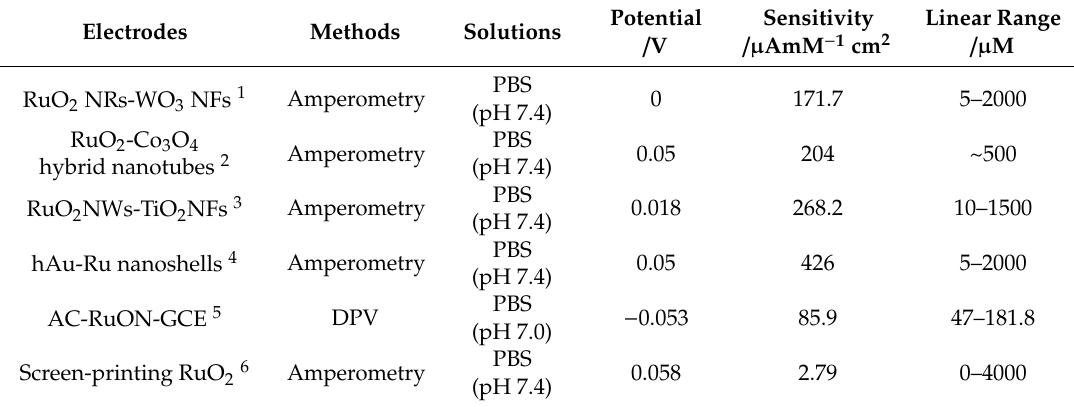
Table 1. Comparison of the analytical performances of previous reported Ru-based AA